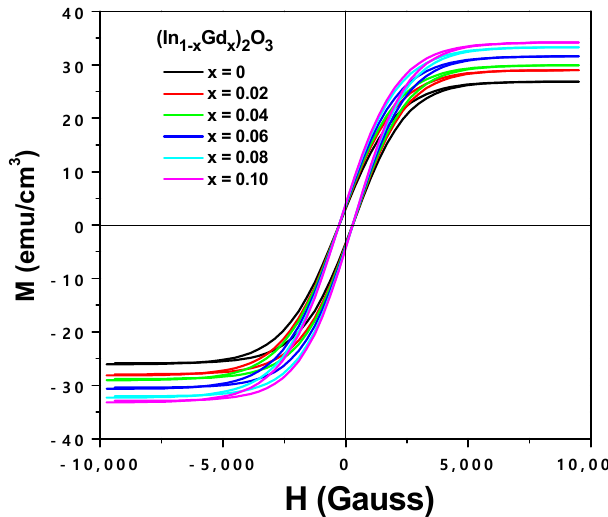
Figure 16. M-H curve for (In 1 − x Gd x ) 2 O 3 thin films. With increasing Gd concentration, (In 1 − x Gd x ) 2 O 3 films become more ferromagnetic at (x = 2, 4, 6, 8, or 10 at.%). The magnetic exchange between Gd +3 and In 3+ surrounding the empty electron trap may be the cause of the enhanced ferromagnetism. Ferromagnetism results from the magnetic exchange of Gd 3+ pairs at the Gd 3+ -F core. As Gd content rises, the saturation magnetization rises as well.